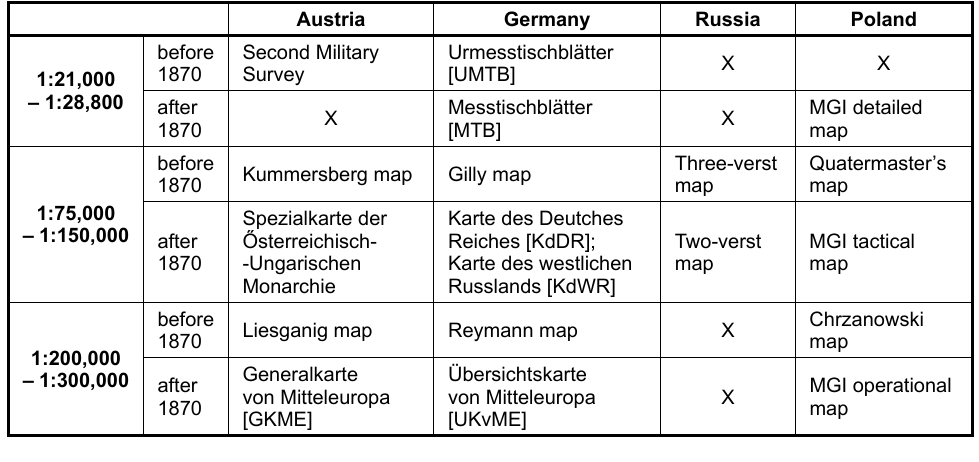
Tab. 2. Matrix of maps fulfilling given criteria. Maps’ short names which are used further are given in square